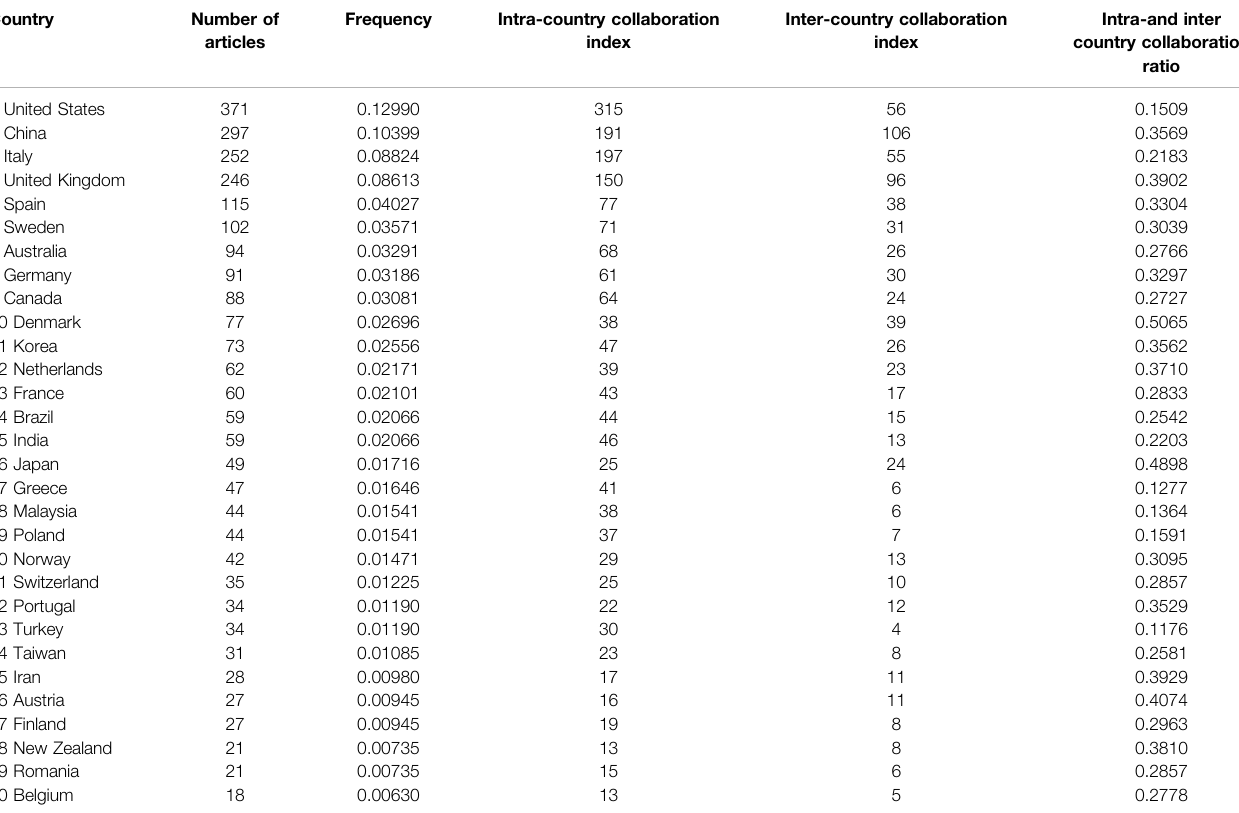
TABLE 2 | Key characteristic features of international publications on household food waste. Country Number of articles